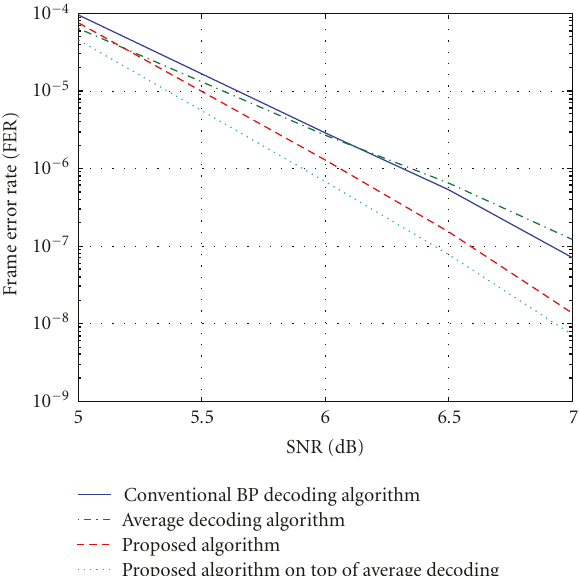
Figure 8: Performance results for RND(1024,512) LDPC code.